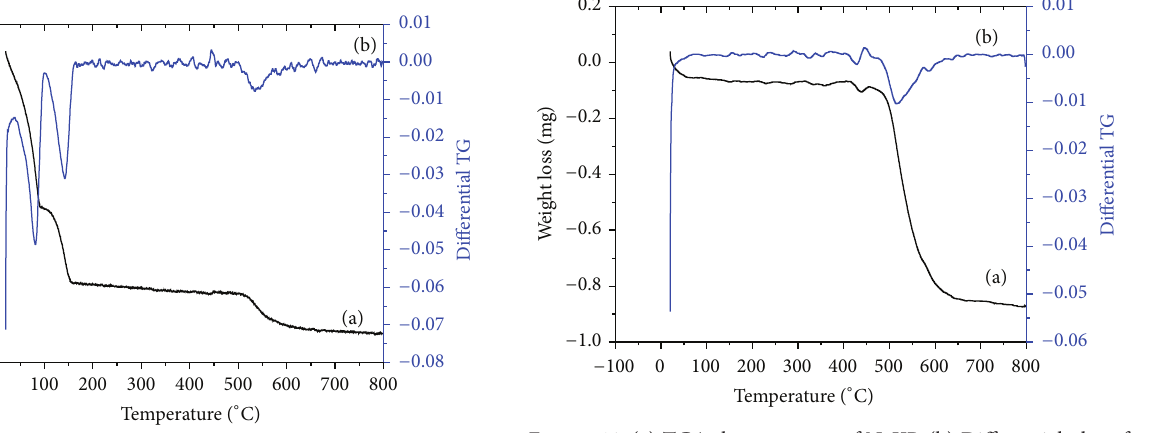
Figure 12: (a) TGA thermograms of KPDMSO. (b) Differential plot of KPDMSO.